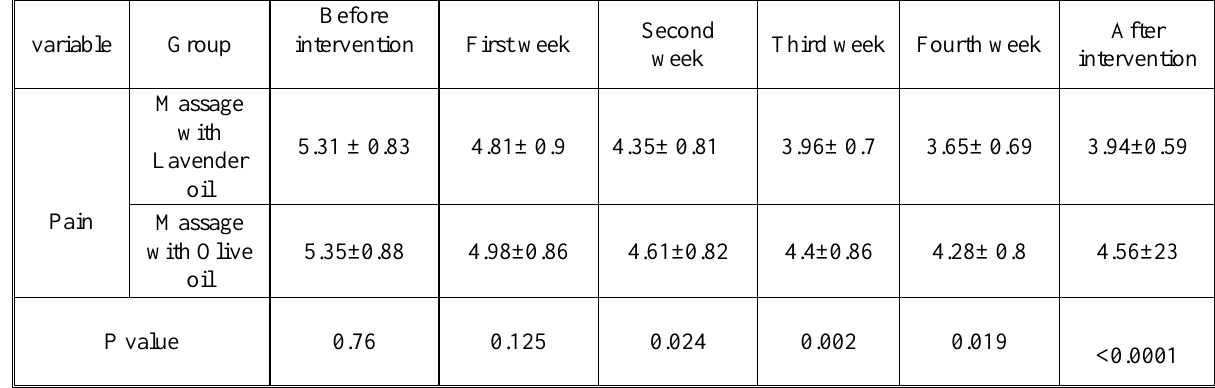
Repeated measure ANOVA test. F= 133.07, DF=